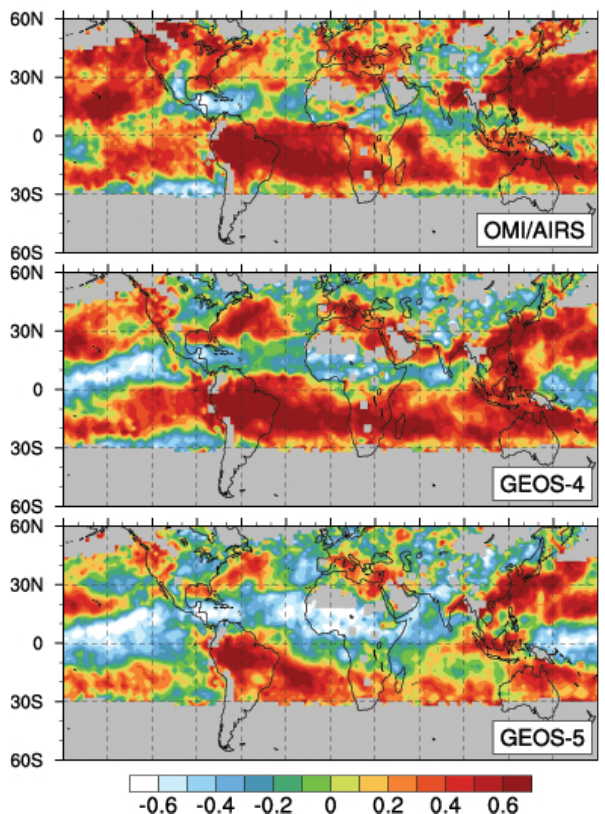
Fig. 4. Ozone–CO correlation coefficients ( r) at 700–400hPa for JJA 2006 from OMI/AIRS and from GEOS-Chem driven by GEOS- 4 and GEOS-5 meteorology. Gray indicates insufficient